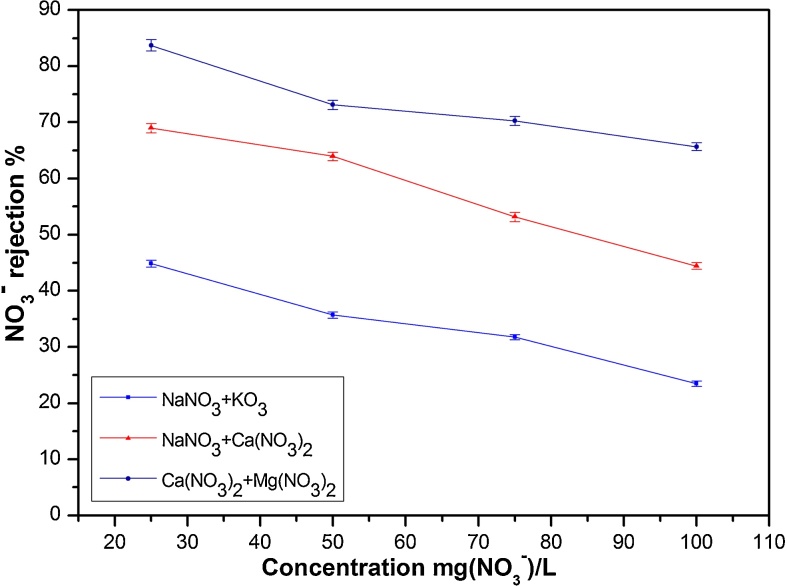
Effect of the concentration on NO3− rejection in ternary solutions (NaNO3 + KNO3), (NaNO3 + Ca (NO3)2),(Ca (NO3)2 + Mg (NO3)2) (at ΔP = 6 bar, and natural pH).